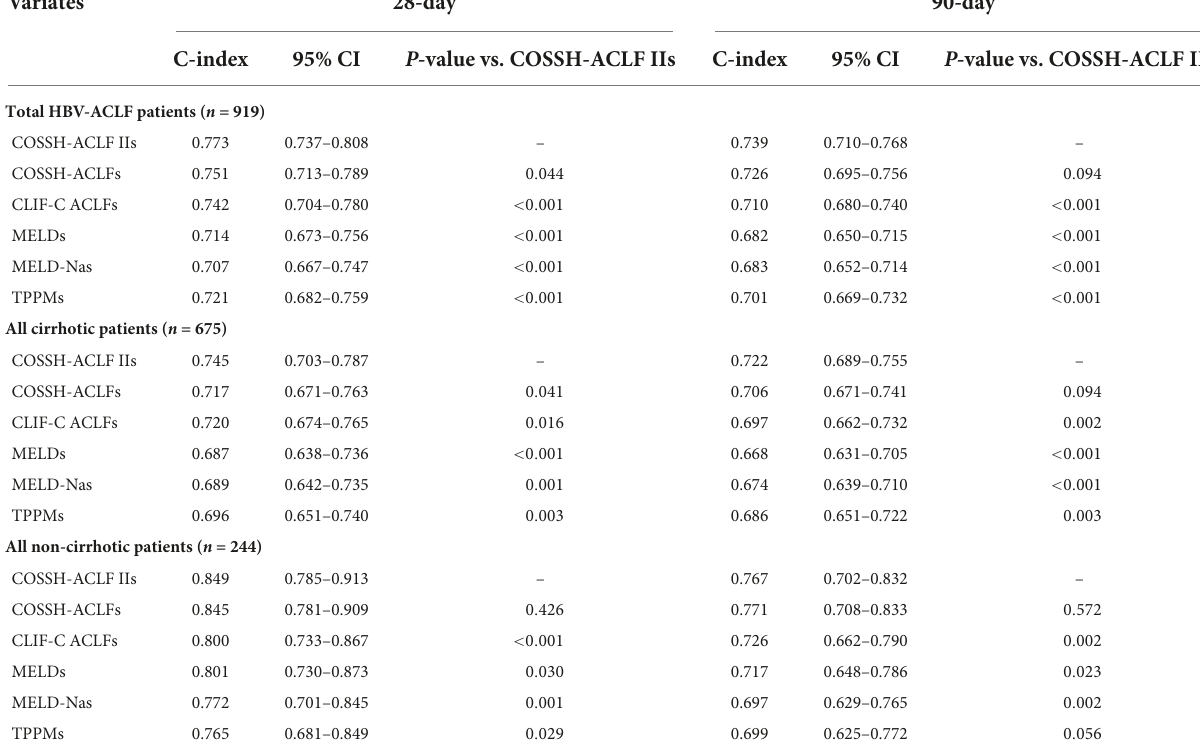
TABLE 2 Comparisons of C-index of prognostic models in predicting short-term mortality in patients with HBV-ACLF (liver transplantation regarded as censored). Variates